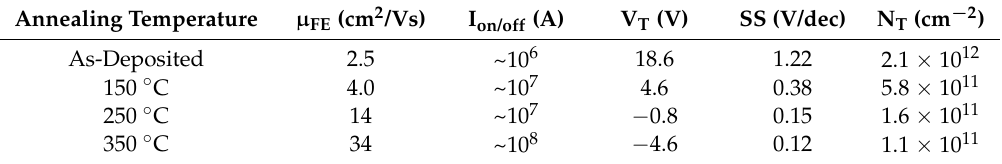
Figure 4. Transfer curve of IZTO thin film transistors deposited at various annealing temperatures in the range of 150–350 °C. Table 4. Summary of transistor parameters of IZTO thin film transistors (TFTs) deposited by RF magnetron sputtering at various annealing temperatures in the range of 150–350 °C.